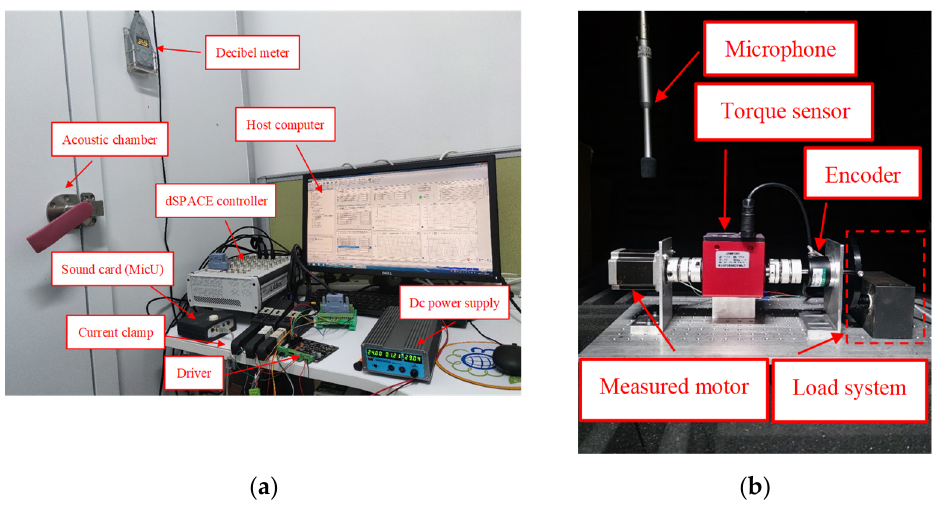
Figure 7. The EM structure of the motor. ( a ) The stator model of the 3P-HSM with 12 slots. ( b ) The rotor model. Table 1. The test equipment type.